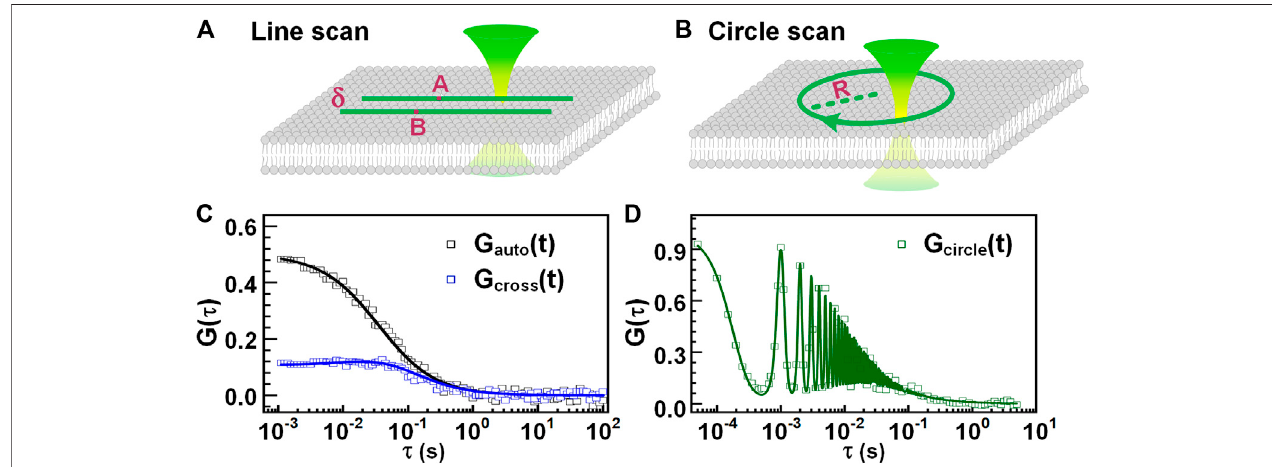
FIGURE 5 | Parallel scanning FCS. Scheme of line-scanning FCS ( A ) and circle-scanning FCS ( B ). ( C ) The autocorrelation curve (black) of a speci fi c pixel and the cross-correlation curve (blue) of two pixels separated by a distance of δ . ( D ) The correlation curve obtained from all the photons assembled with time, regardless of scanning